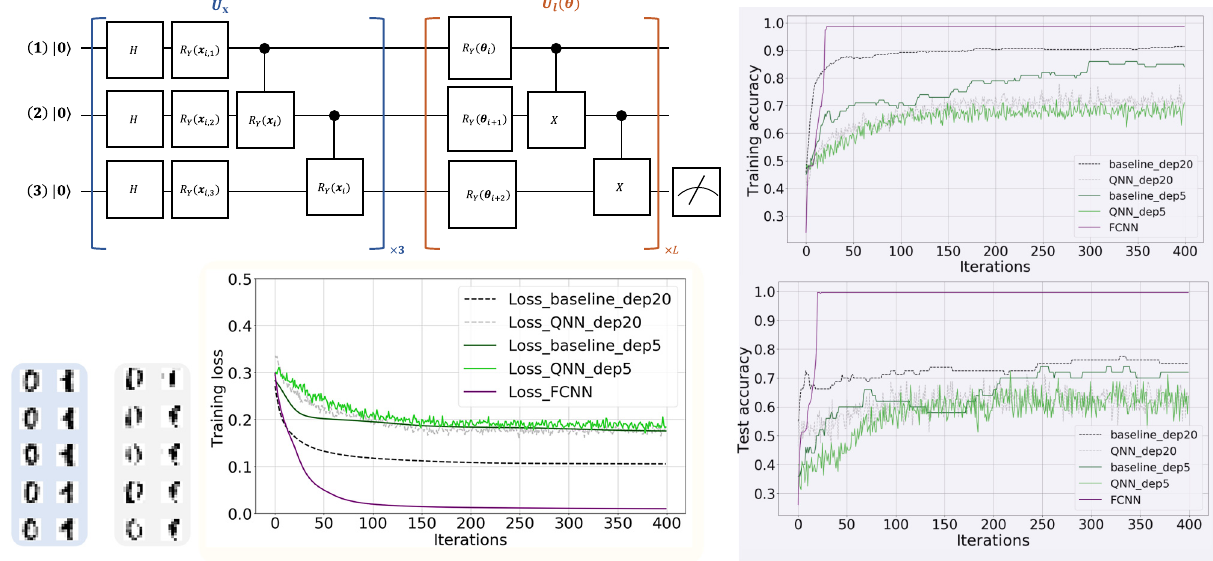
FIG. 2. The simulation results of using QNN to learn a handwritten digit dataset. The lower left panel illustrates the original and reconstructed training examples, as highlighted by the blue and gray regions, respectively. The upper left panel shows the implemen- tation of the data encoding circuit and trainable circuit used in QNN. The label “ × 3” and “ × L ” means repeating the quantum gates in blue and brown boxes with 3 and L times, respectively. The lower center panel, highlighted by the yellow region, shows the training loss under different hyperparameter settings. In particular, the label “Loss_baseline_depL” refers to the obtained loss with circuit depth L (i.e., L = 20 or L = 5), p = 0, and K → ∞ , where p , and K refer to the depolarization rate and the number of measurements to estimate expectation value used in QNN. Similarly, the label “Loss_QNN_depL” refers to the obtained loss of QNN with setting the circuit depth as L (i.e., L = 5, 20), p = 0.0025, and K = 20. The label “Loss_FCNN” represents the obtained loss of FCNN. The upper right and lower right panels separately exhibit the training and test accuracy of FCNN and QNN with different hyperparameter